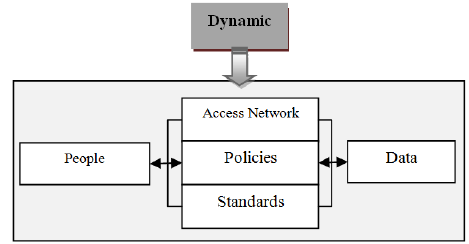
Figure1. Nature and relations between SDI components (Rajabifard et al 2003)